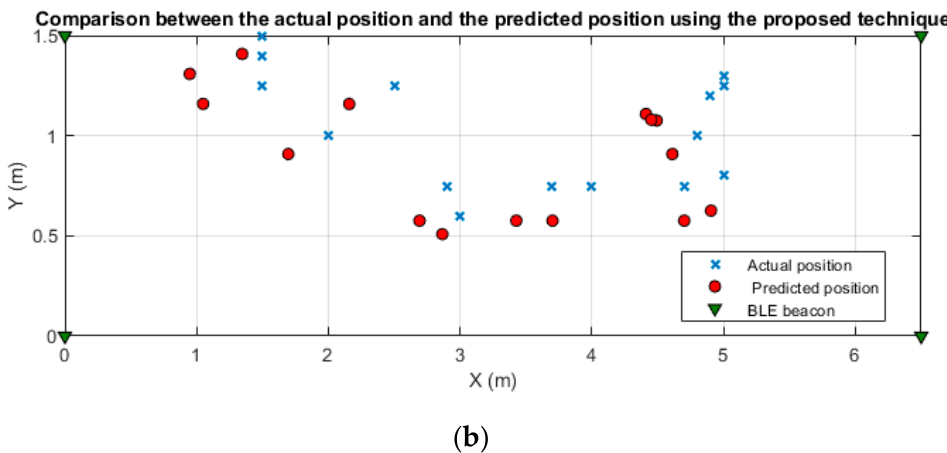
Figure 12. Comparison between the actual test points position and the predicted position using the proposed enhanced centroid algorithm at: ( a ) The office room; ( b ) The corridor.